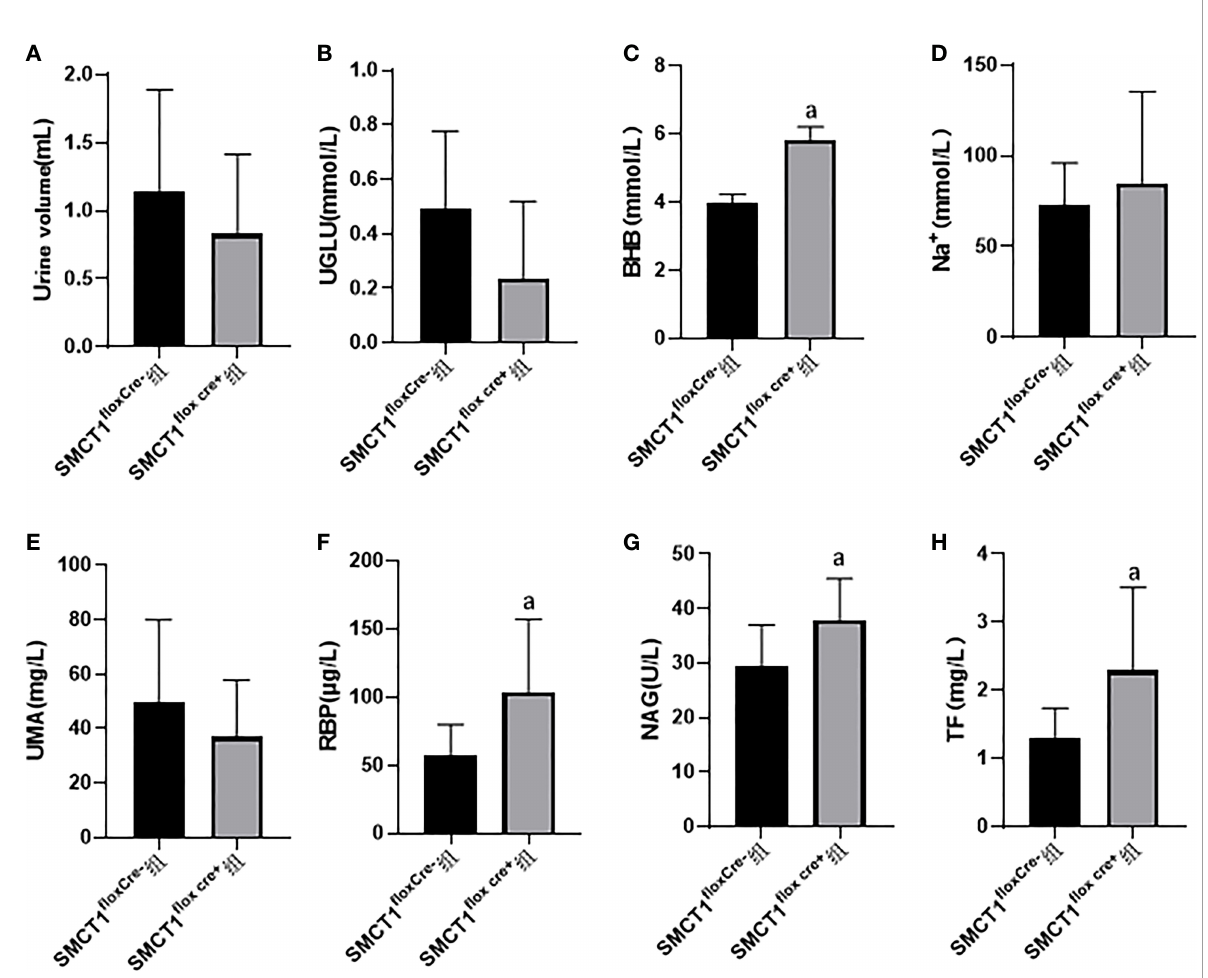
FIGURE 2 Roles of SMCT1 in tubular protection in mice starved for 48 h. SMCT1 fl ox cre+ represents SMCT1 fl ox/ fl ox cre+ mice with speci fi c SMCT1 gene knockout in renal tubules, and SMCT1 fl ox cre- represents wild-type SMCT1 fl ox/ fl ox cre- mice. The level of urine volume (A) , UGLU (B) , urine BHB (C) , urine Na+ (D) ,UMA (E) , RBP (F) , NAG (G) , and TF (H) in two groups of mice. UGLU, urine glucose; BHB, urine b -hydroxybutyrate; Na + , urine sodium ion; UMA, microalbuminuria; RBP, urine retinol binding protein; NAG, urine N-acetyl - b – glucosaminidase; and TF, transferrin. a p < 0.05, compared with the SMCT1 fl ox cre-